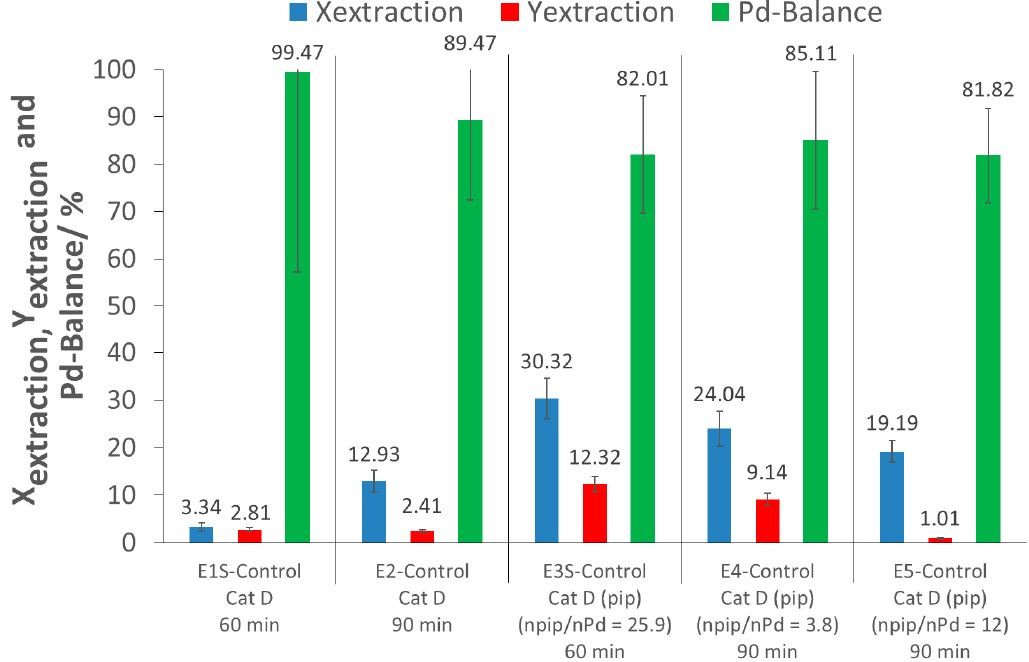
Figure 3. Results of the control tests ((pip): piperidine; npip/nPd: molar ratio of piperidine to Pd; ExS-Control: Screening experiments; Ex-Control: Detailed investigation experiments).